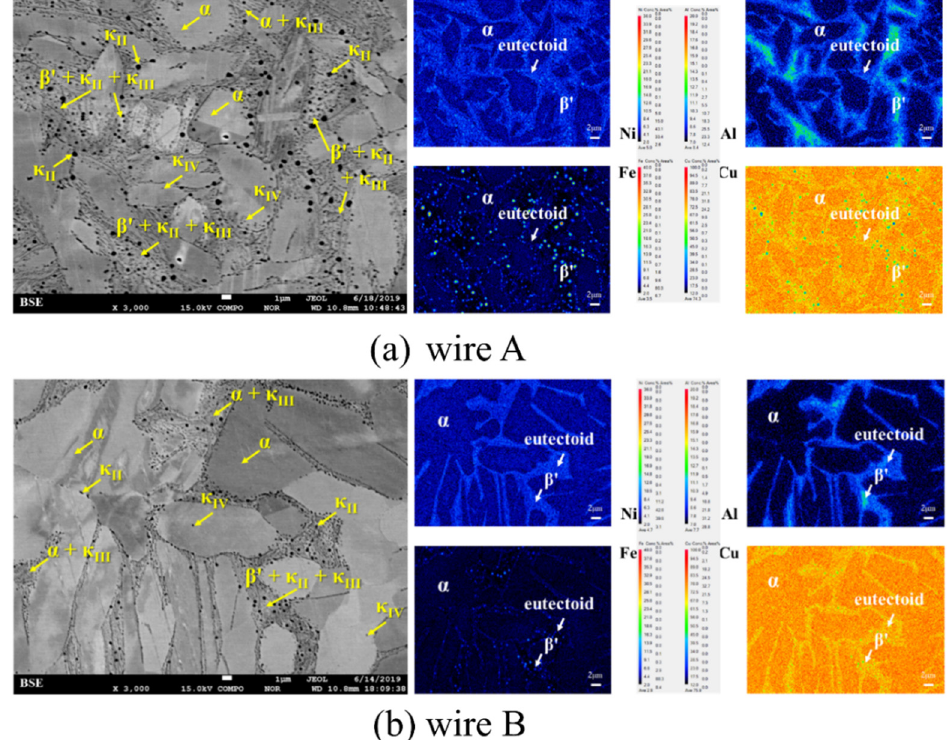
Figure 8. Phase analysis of intermetallic phase and EPMA results on additively-manufactured NAB components made in ( a ) wire A; ( b ) wire